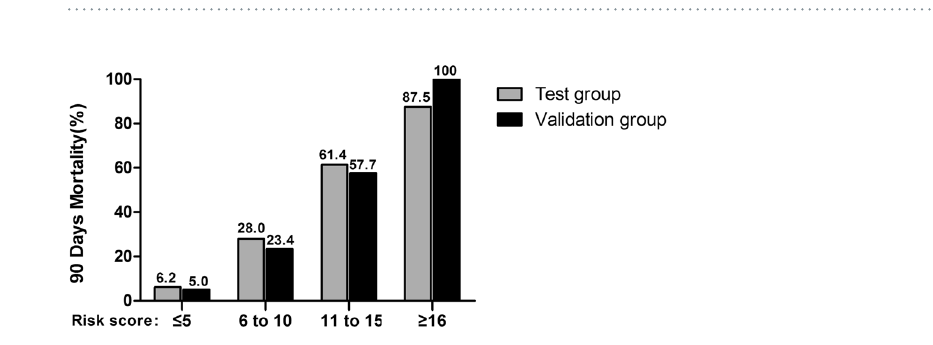
Figure 5. Corresponding 90-day morality for different level of new score between test group and validation